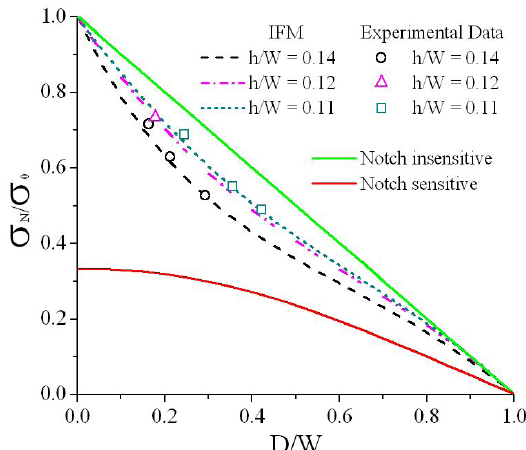
Figure 6. Comparison between the adapted IFM method proposed by Equation 18 and the experimental